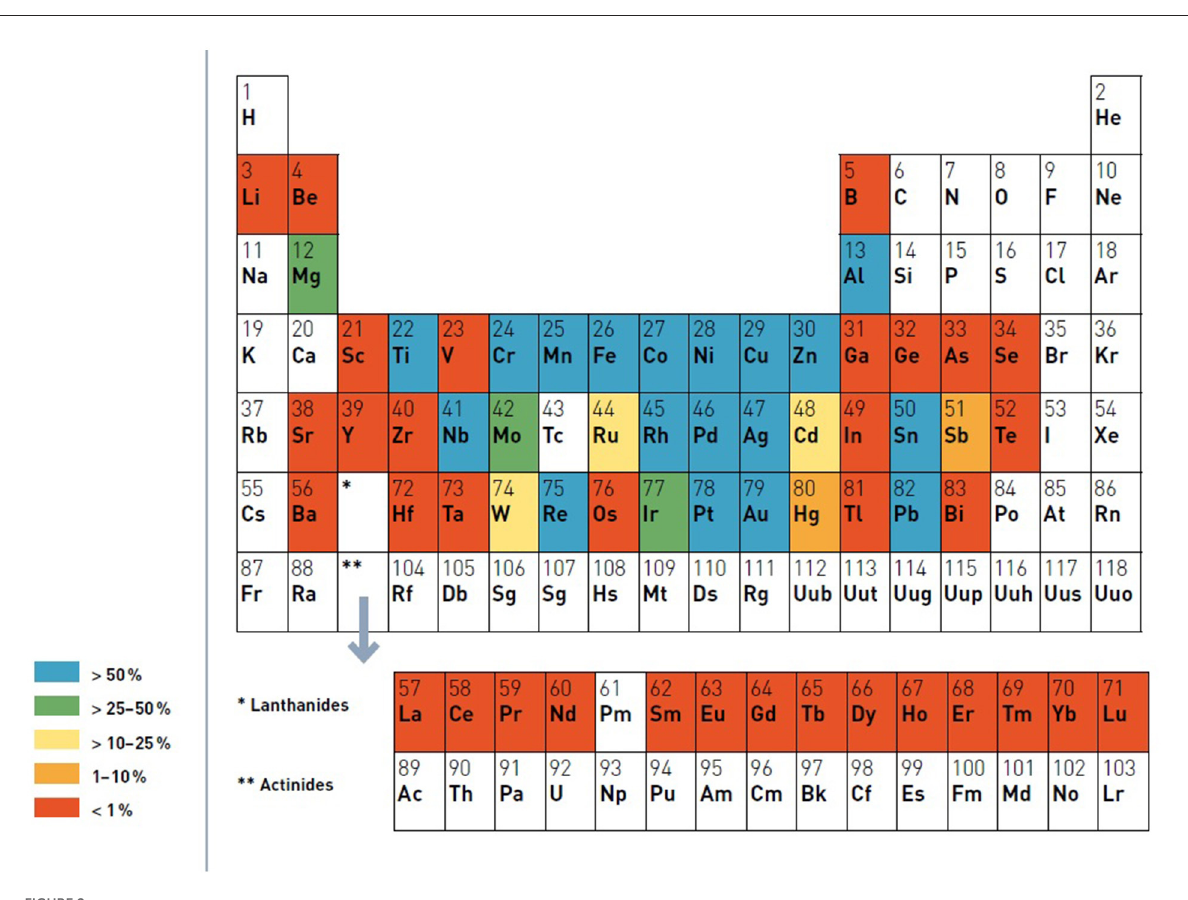
FIGURE2 The periodic table of global average end-of-life functional recycling for sixty metals. Source: UNEP